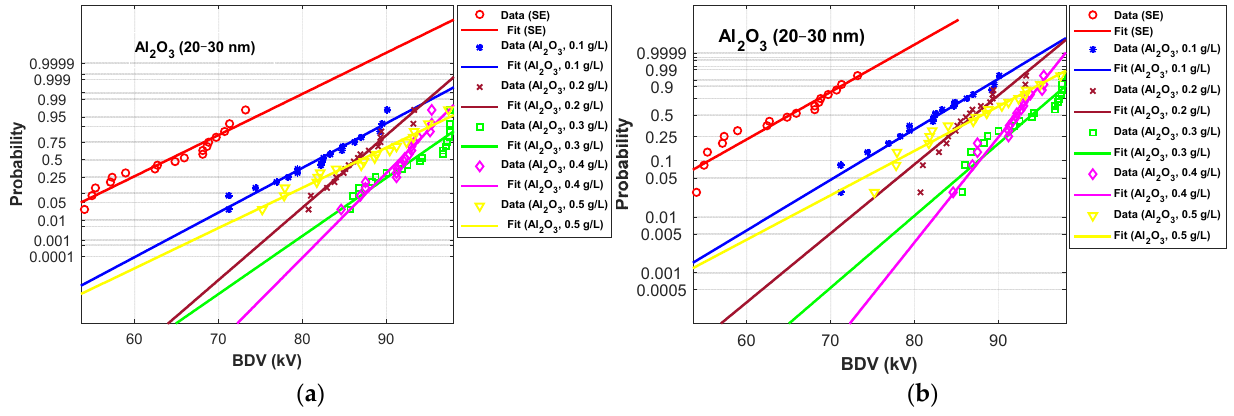
Figure 15. Probability plot of breakdown voltage data of SE-based nanofluids with Al 2 O 3 (20–30 nm) for the 2 mm electrode gaps; ( a ) normal and ( b ) extreme value.